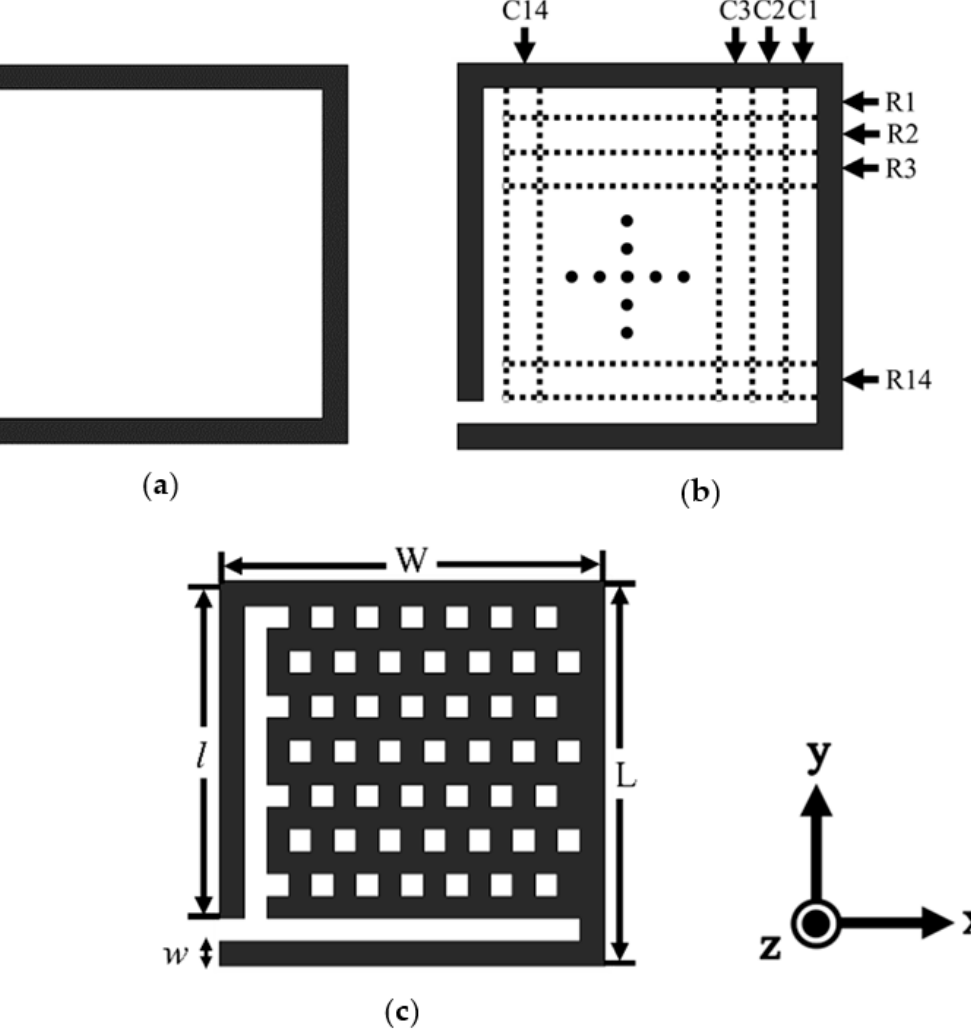
Figure 1. Metallic loading in square open-loop resonator: ( a ) square open-loop resonator; ( b ) equally divided small cell grid; ( c ) geometry of square mesh open-loop resonator.